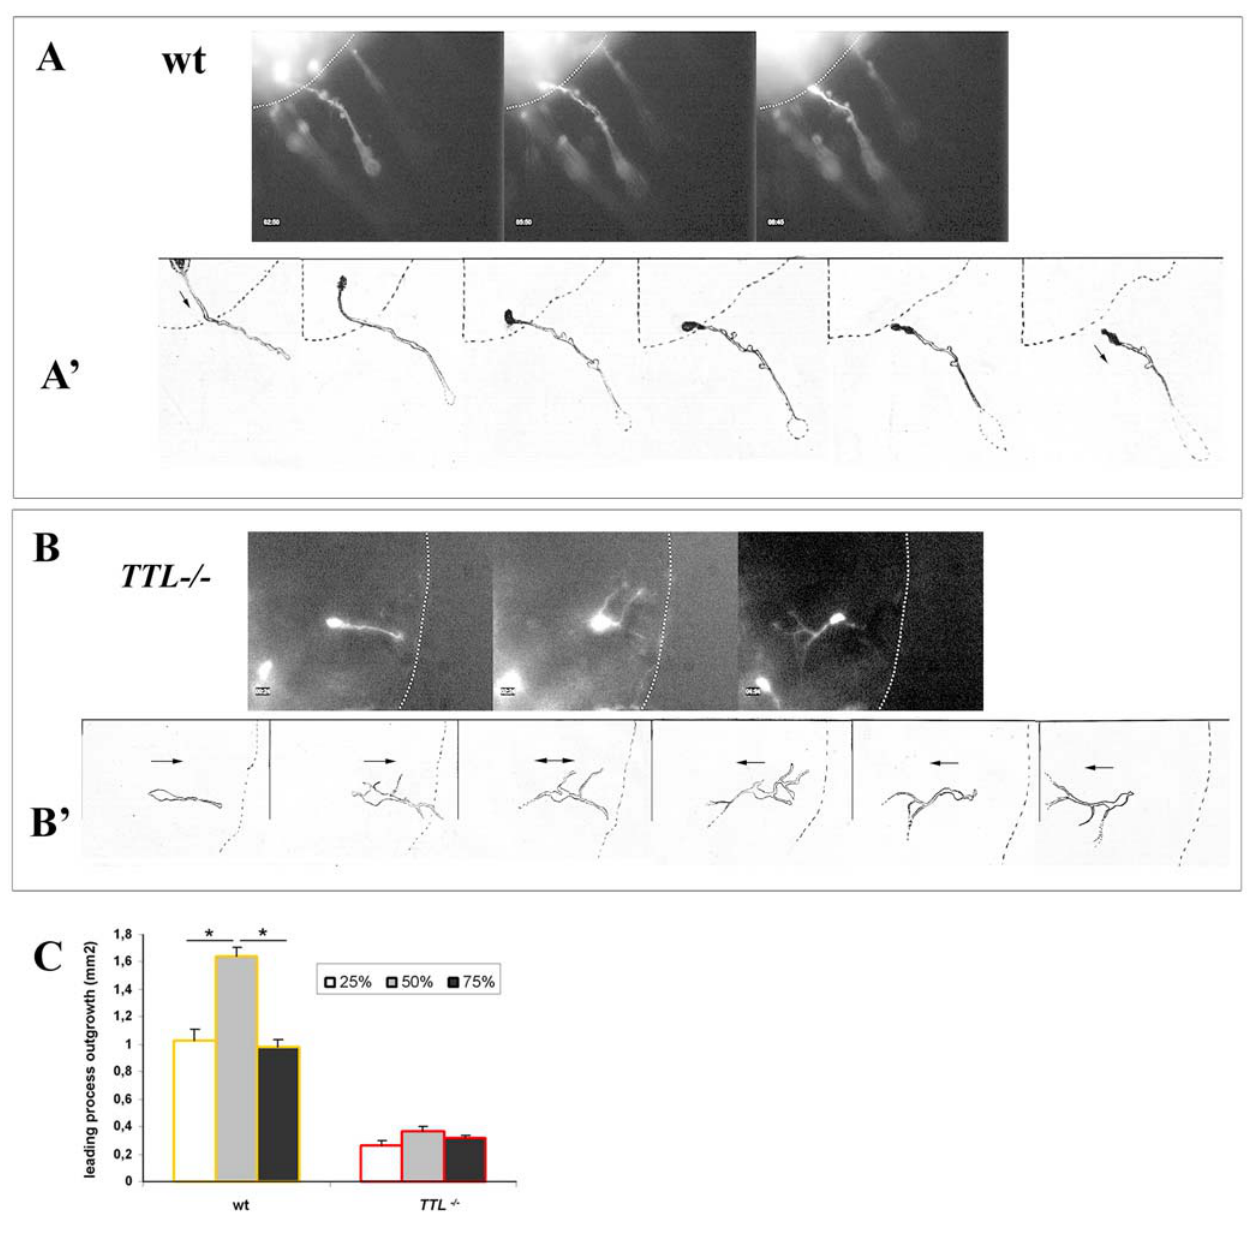
Figure 6. Distinct behaviours of E12.5 GFP-electroporated PCN neurons from wt and TTL 2 / 2 embryos at the edge of rhombic lip explants. (A, B) Single GFP-electroporated neurons from wt (A and Movie S3 in supplementary material) and TTL 2 / 2 embryos (B and Movie S4 in supplementary material) were recorded after 2 DIV, inside the explants, at the moment they intended to leave it to enter the collagen matrix to go toward the Netrin-1 source. While wt neurons could easily exit the explants to enter the collagen matrix, TTL 2 / 2 neurons emitted numerous primary or secondary sensing neurites when contacting the edge of the explants (dashed line) and failed to enter the collagen matrix, finally changing their growth direction. Drawings of single neurons provided a sequential representation of the behaviour of wt (A’) and TTL 2 / 2 (B’) neurons. Black arrows in drawings indicate the direction of migration. (C) Bar graphs showing quantification of total axon outgrowth of wt and TTL 2 / 2 explants placed in collagen matrix of distinct concentration. Changing the density, and thus, the softness of the substrate, has no effect on total axon outgrowth of TTL 2 / 2